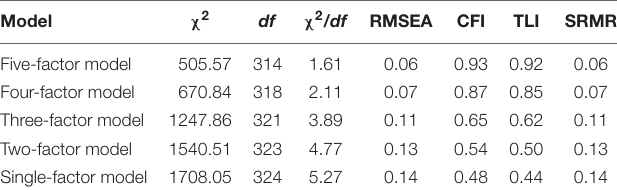
TABLE 1 | Results of confirmatory factor analysis ( N =